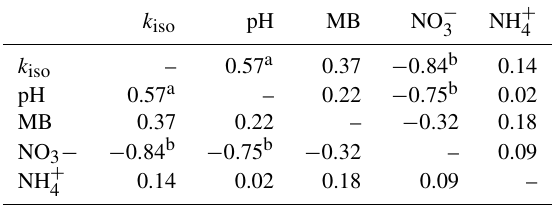
a indicates p < 0 . 05 and b indicates p < 0 . 01